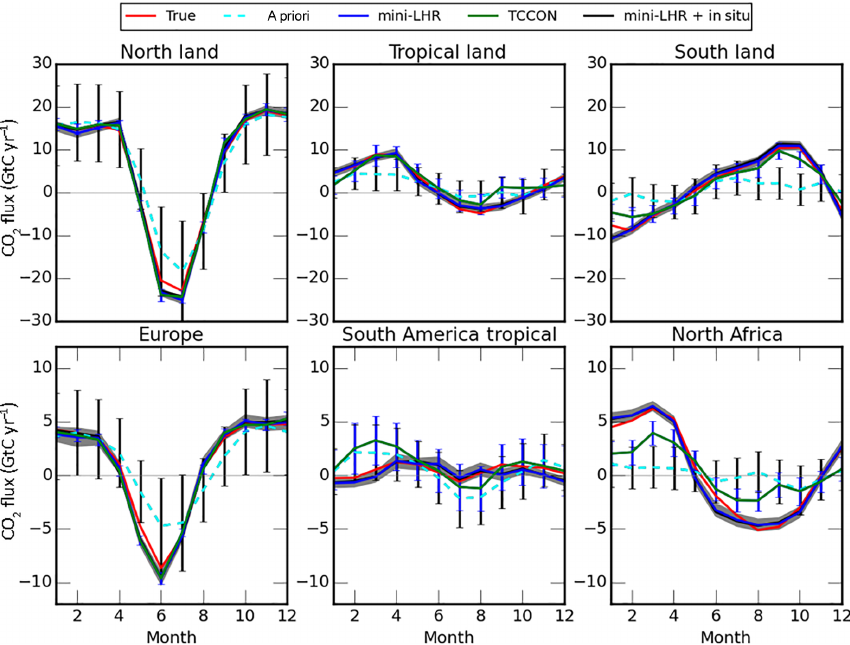
Figure 8. True, a priori, and a posteriori monthly CO 2 fluxes (GtCyr − 1 ), described over large-scale geographical regions for our study year. Vertical lines and the grey shading denote uncertainties associated with the a priori fluxes and the a posteriori fluxes inferred from the mini-LHR and NOAA in situ flask networks, respectively.